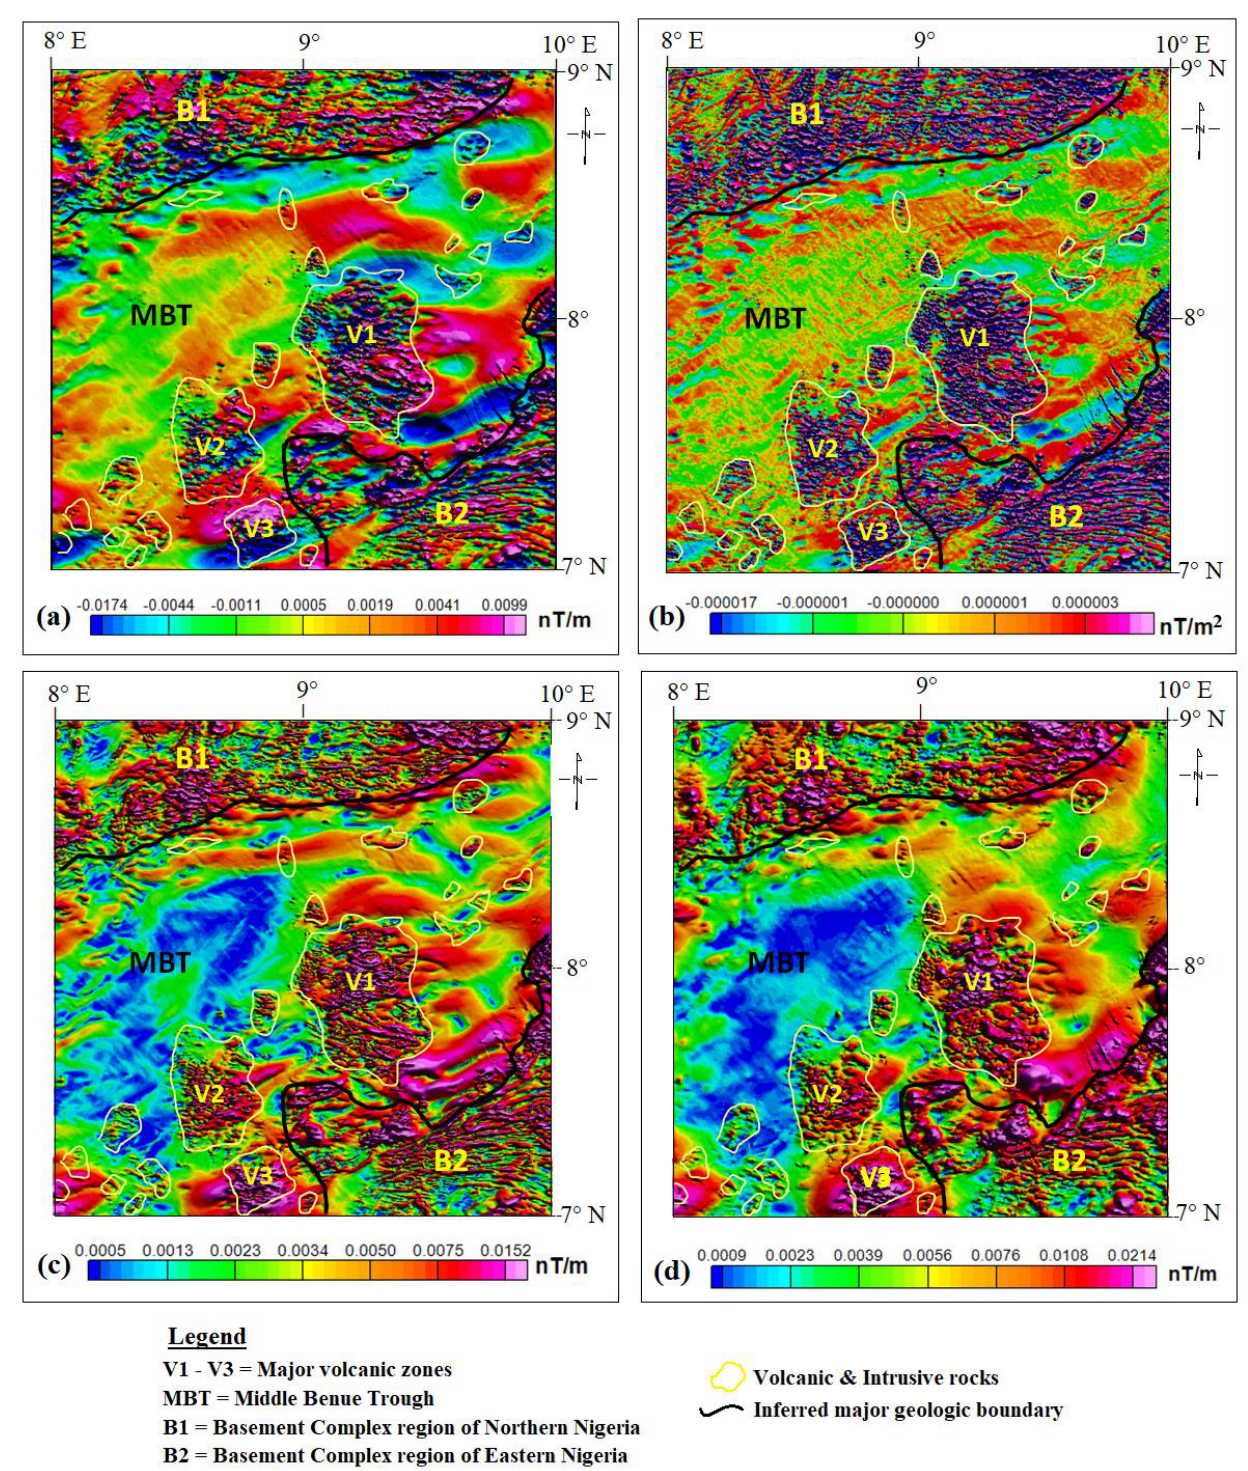
Figure 6. Magnetic derivatives maps of the study area depicting the sedimentary–basement contact, as well as volcanics and intrasedimentary features. ( a ) 1VD. ( b ) 2VD. ( c ) THDR. ( d ) AS.